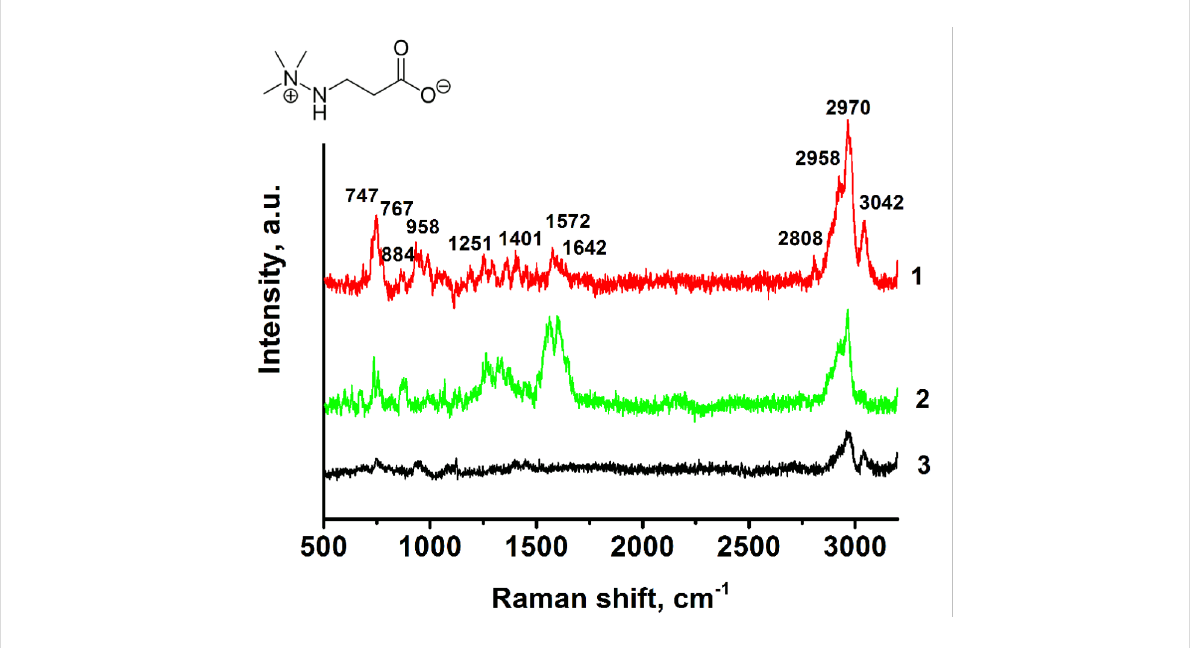
Figure 5: SERS spectra of mildronate in (1) 10 − 3 M and (2) 10 − 2 M concentrations collected using mp-Ag/Ag slides prepared in the presence of PVP. The volume of the aliquot was 2 μ L. As a reference sample, 2 µL of 100 mg/mL standard solution was dried on the glass substrate (3). The excitation laser was 514.4 nm, at 5% power of 20 mW, and 10 s acquisition time.